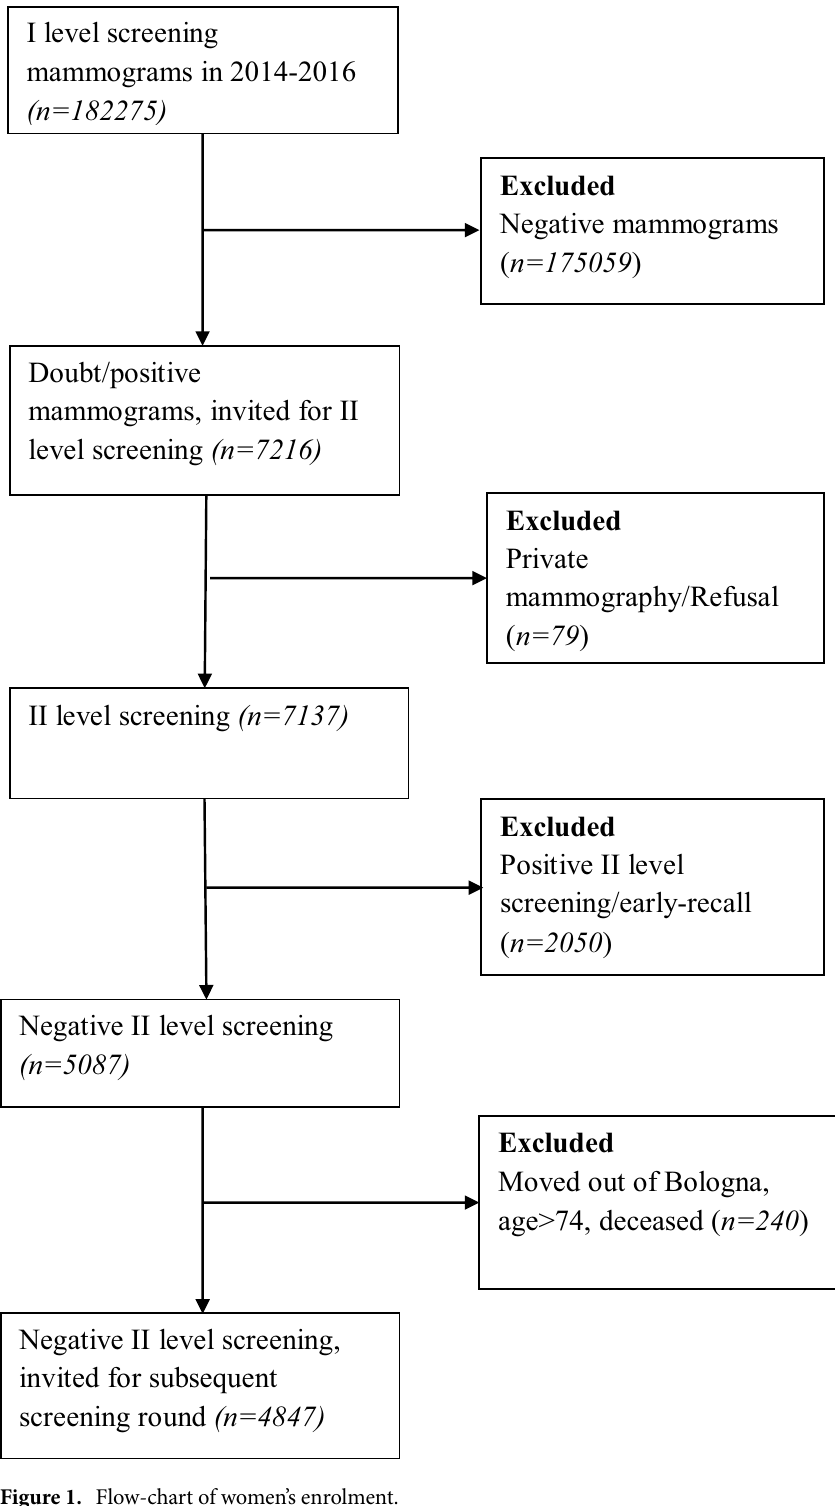
Figure 1. Flow-chart of women’s